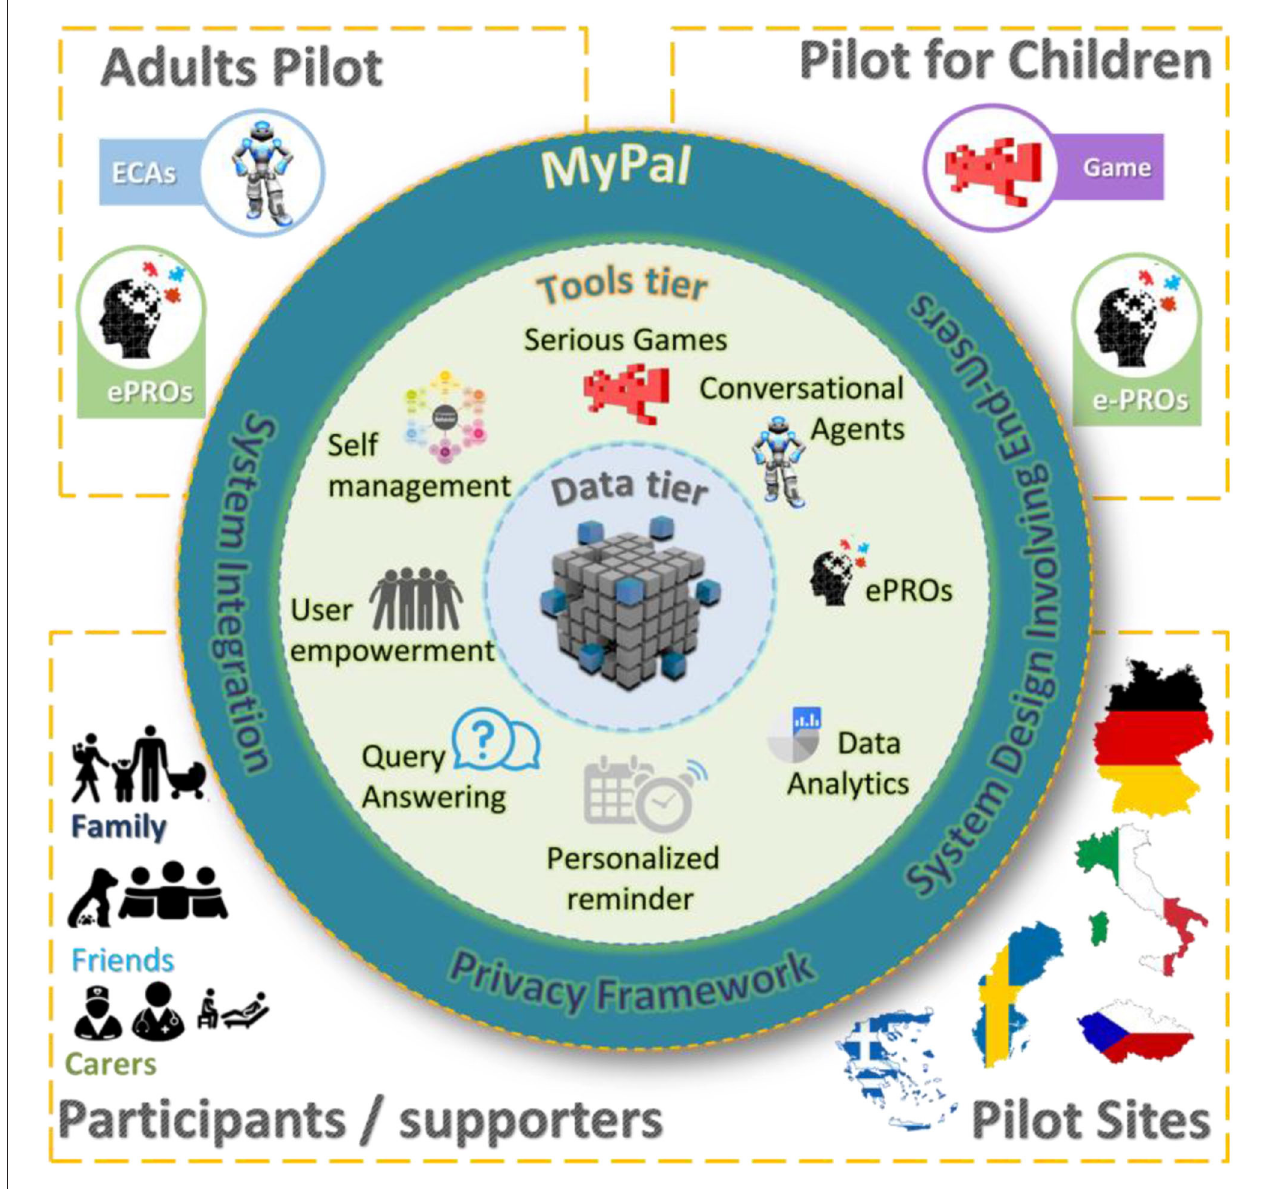
FIGURE 1 | MyPal conceptual